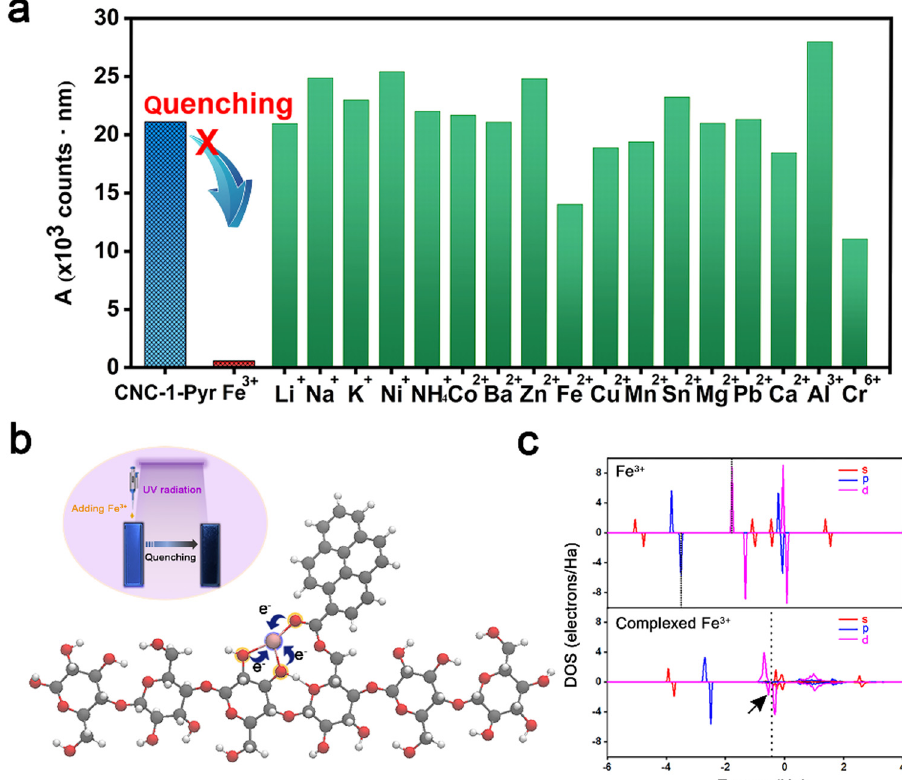
Figure 3: Fluorescence quenching of CNC - 1 - Pyr for speci fi c detection of Fe 3 + : ( a ) integral area of emission peaks calculated from the fl uor - escence emission spectra, ( b ) stable conformation of CNC - 1 - Pyr after complexing with Fe 3 + . The inset is the digital photos of the CNC - 1 - Pyr solution before and after fl uorescence quenching. ( c ) DOS of free Fe 3 + and Fe 3 + @CNC - 1 - Pyr complex. The dotted lines refer to the Fermi levels. The arrow points out the captured electron from adjacent O